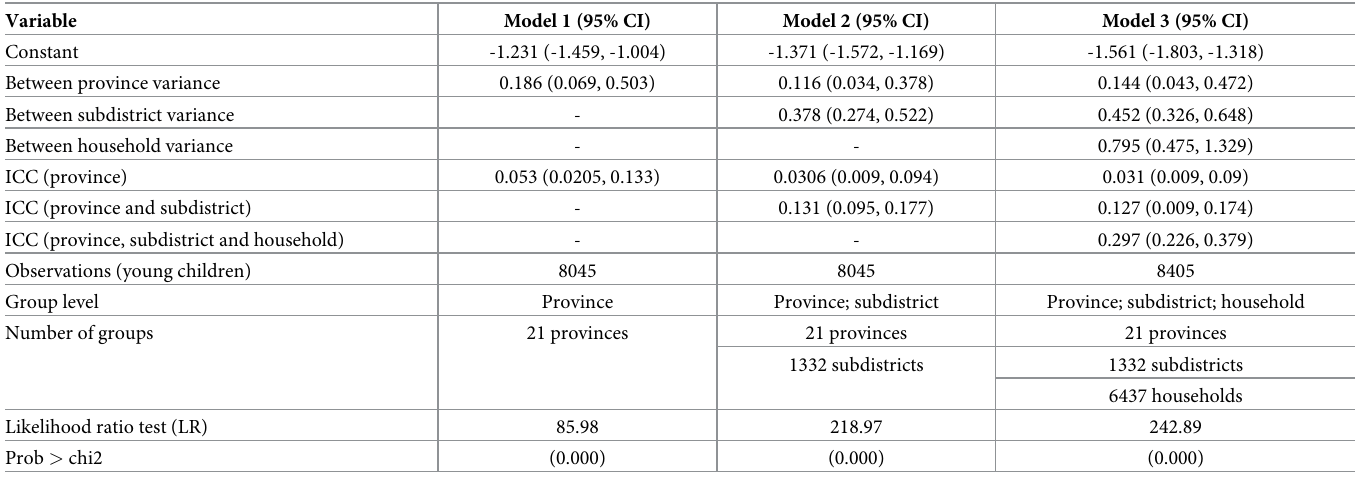
Table 2. Null models: With province effects (Model 1), province and subdistrict effects (Model 2) and province, subdistrict and household effects (Model 3).